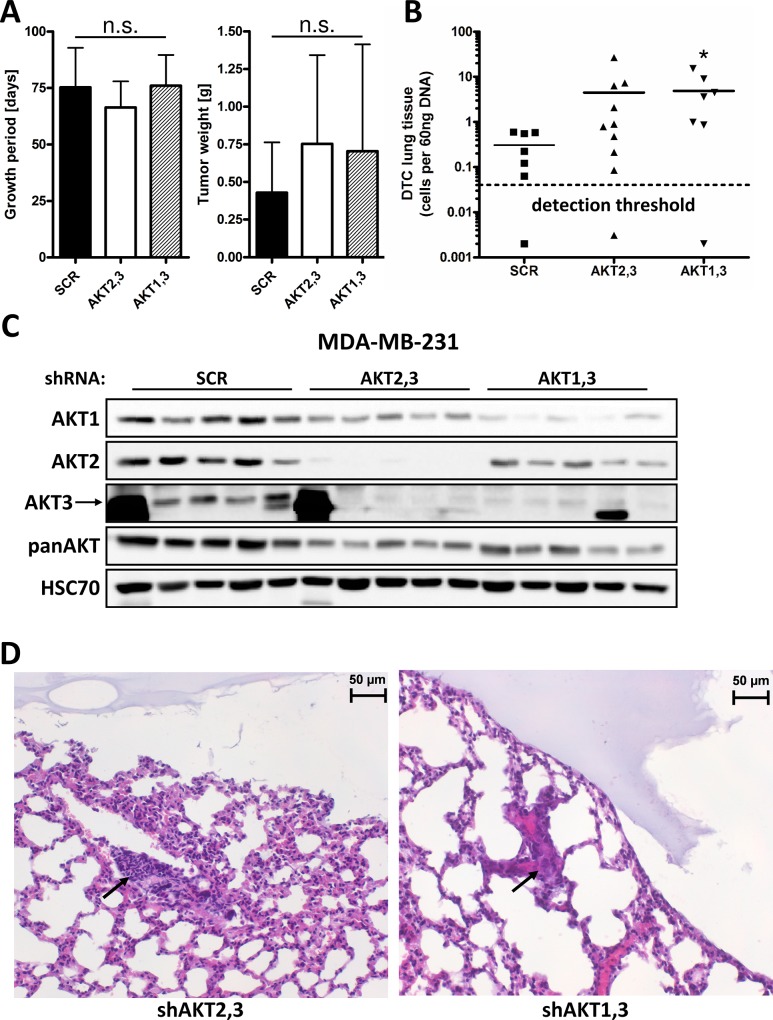
Knockdown of AKT3 increases the metastatic potential of MDA-MB-231 cells in vivo.AKT2,3 and AKT1,3 double knockdown cells as well as control cells were injected subcutaneously into SCID mice (8 to 10 mice per group). Tumors were allowed to grow until a termination criterion was met. (A) Growth period and tumor weight upon necropsy (Bars: SD, ns., p>0,05). (B) The number of disseminated tumor cells in the left lung of mice was quantified by Alu-PCR. (Bars: SD, *, p<0,05) (C) Protein lysates were prepared from 5 tumors per group, and AKT isoform knockdown were analyzed by Western blot. (D) Representative images from histological examination of the right lungs from mice injected with AKT2,3 and AKT1,3 knockdown cells showing macroscopically detectable metastases.